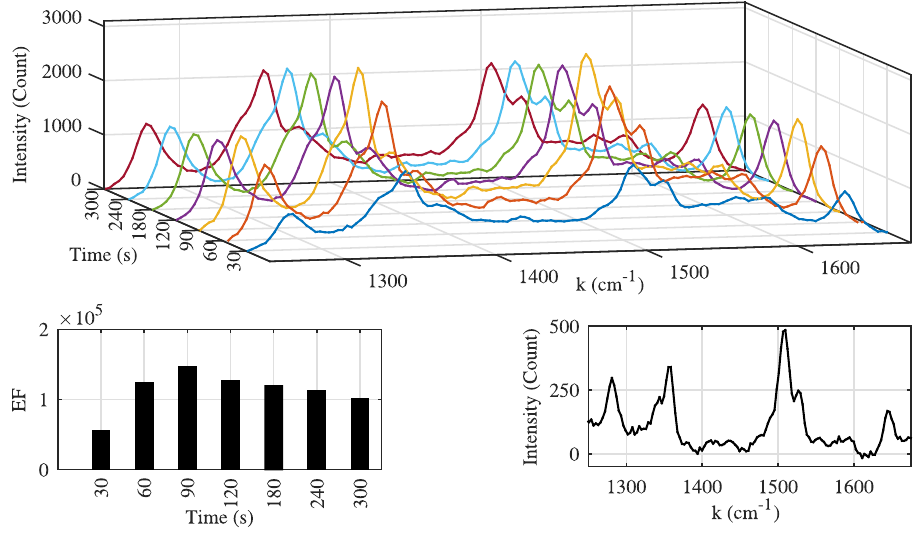
Figure 5. Enhancement factor ( EF ) of 5 μ M RhB variation for different electrolysis time. For electrolysis time of 90 seconds the EF for the Raman peaks of 1509 cm − 1 reaches the maximum value of above 5 orders of magnitude. All of the spectrums were recorded in one second with laser power of 250 mW , and the reference spectrum was recorded with 100 mM RhB concentration.